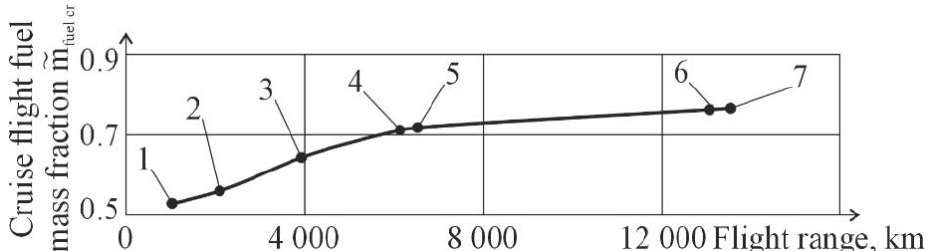
m versus flight range: 1 — Yak-40 with Figure 7. Dependence of cruise flight fuel mass fraction (cid:101) m fuel cr versus flight range: 1—Yak-40 with Figure 7. Dependence of cruise flight fuel mass fraction f u e l c r flight range 1000 km; 2—Tu-134 with flight range 2100 km; 3—Tu-154M with flight range 3900 km; flight range 1000 km; 2 — Tu-134 with flight range 2100 km; 3 — Tu-154M with flight range 3900 km; 4—Airbus A320-200 with flight range 6100 km; 5—Airbus A310-300 with flight range 6500 km; 4 — Airbus A320-200 with flight range 6100 km; 5 — Airbus A310-300 with flight range 6500 km; 6 — 6—Boeing 777-200 with flight range 13,000 km; 7—Boeing 747-400 and Airbus A340-300 with flight Boeing 777-200 with flight range 13,000 km; 7 — Boeing 747-400 and Airbus A340-300 with flight range 13,500 range 13,500 km.